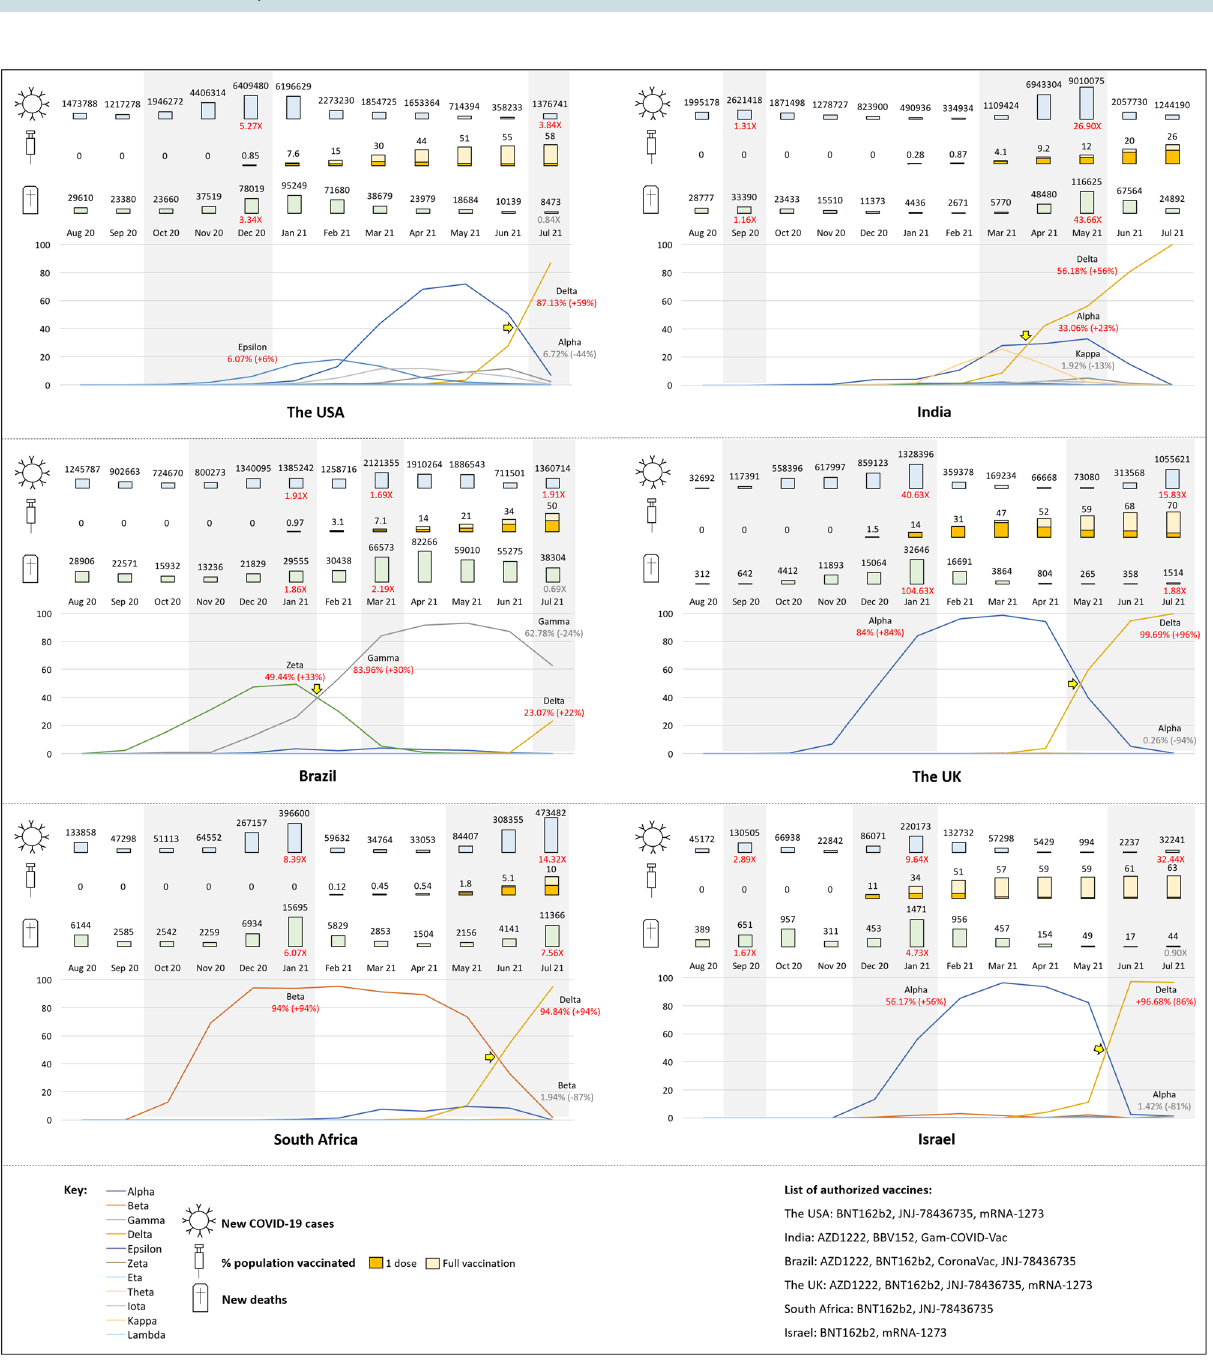
cases and deaths increased by 8.39 and 6.07 folds, respectively. Vaccination coverage was 0%, and Beta VOC expanded to 93.89% in January 2021. The second one has started from May to July 2021, with 14.32- and 7.56- fold peak growth of new cases and deaths, respectively. By July 2021, Delta VOC (94.84%) has overridden Beta VOC (1.94%), and only 10% of population was vaccinated. In South Africa, BNT162b2 (Pfizer-BioNTech) and JNJ-78436735 (Janssen) vaccines were rolled out for administration 18 .